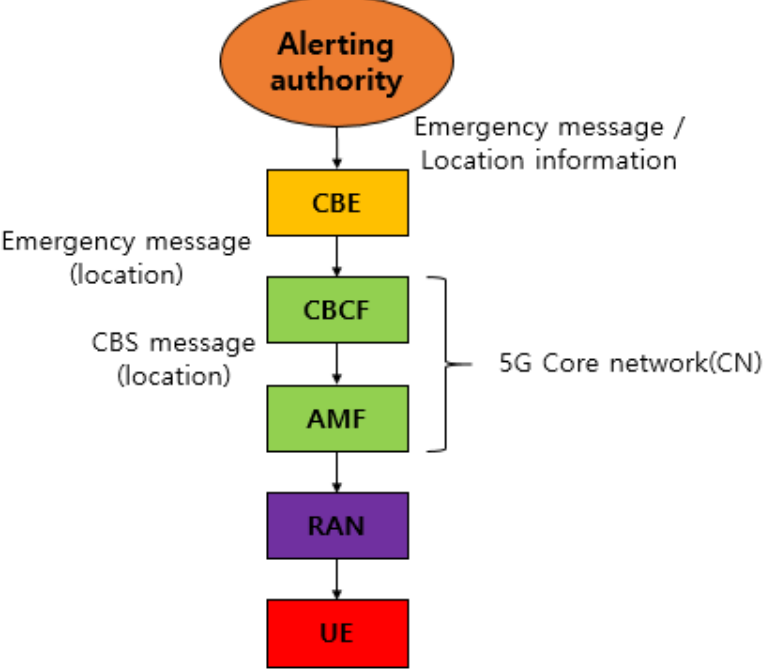
Figure 1. The network architecture for the 5G CBS.